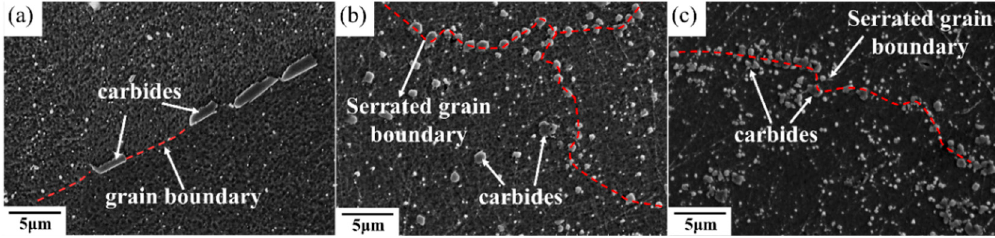
Figure 8. Scanning electron microscope images of ( a ) STA-1180 °C/4 h, ( b ) as-HIPed, and ( c ) HIP+ direct aging specimens.